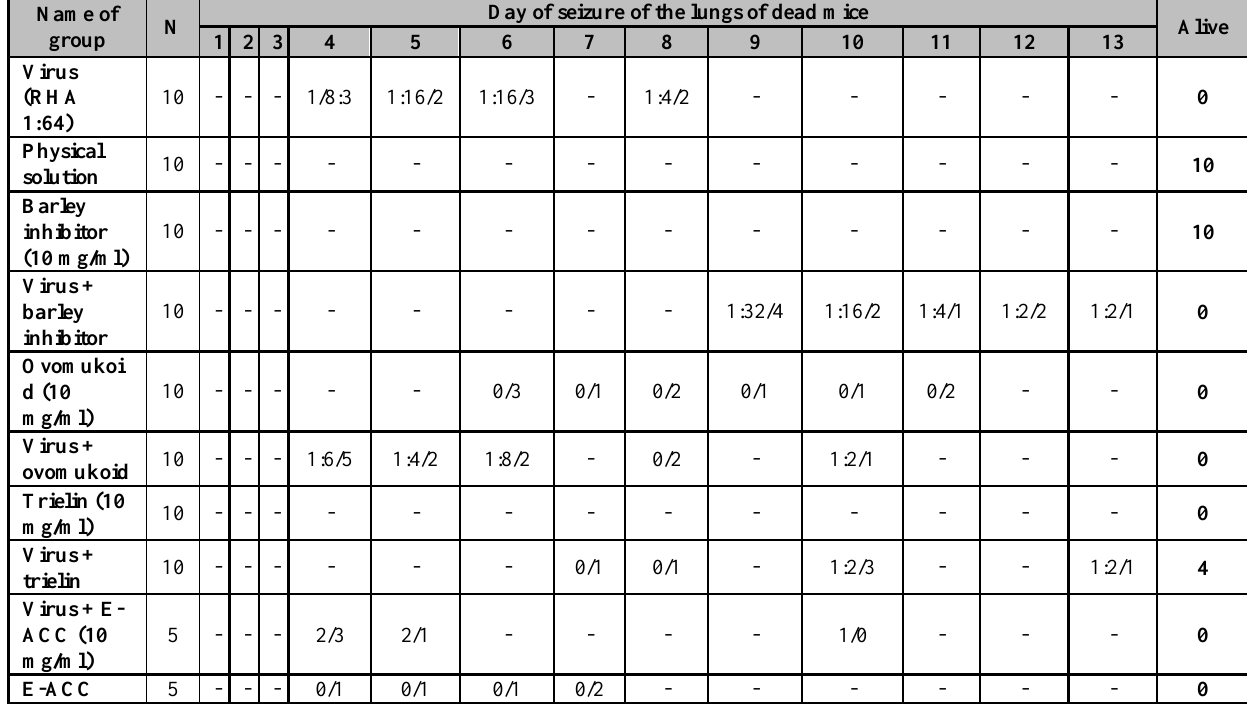
Table 4. The presence of hemagglutinating activity in the lungs of dead mice infected with a lethal dose of influenza virus A/P/R/8/34 and treated with trypsin